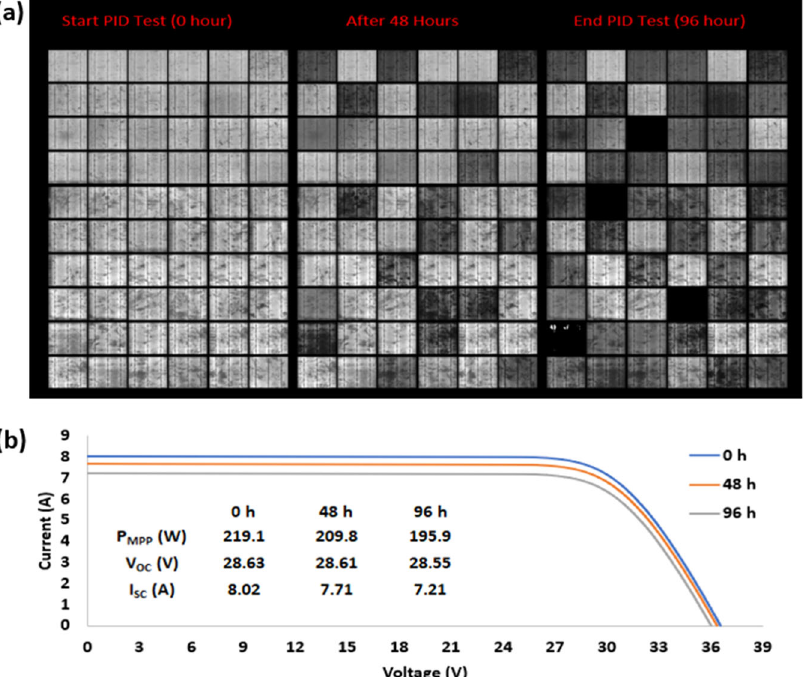
Fig. 2 Results of the PID test. a EL image of a PV module before and after the PID test is performed at 0, 48, and 96 h. b Measured I – V curves under the standard test conditions.